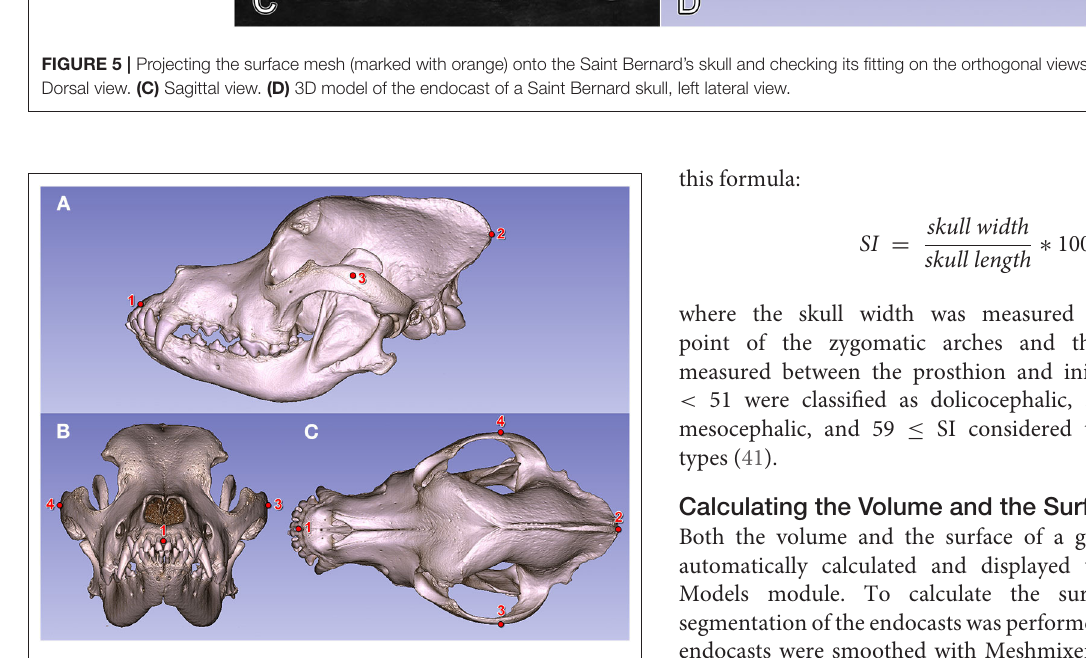
FIGURE 6 | Fiducial markers on a Saint Bernard’s skull (volume-rendered model). (A) Left lateral view. (B) Rostral view. (C) Dorsal view. (1) Prosthion. (2) Inion. (3) Widest point of the left zygomatic arch. (4) Widest point of the right zygomatic